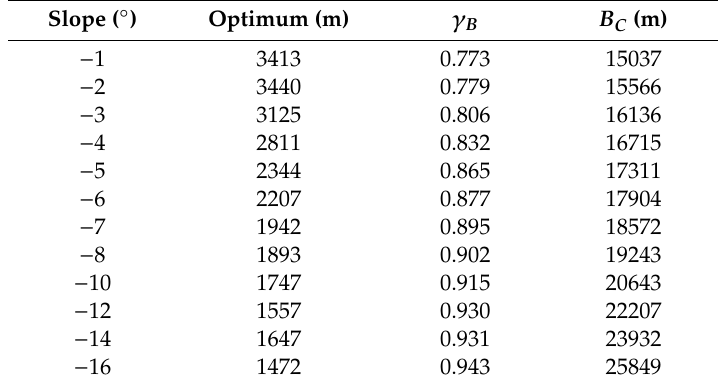
Table 2. Optimal perpendicular baselines for di ff erent negative terrain